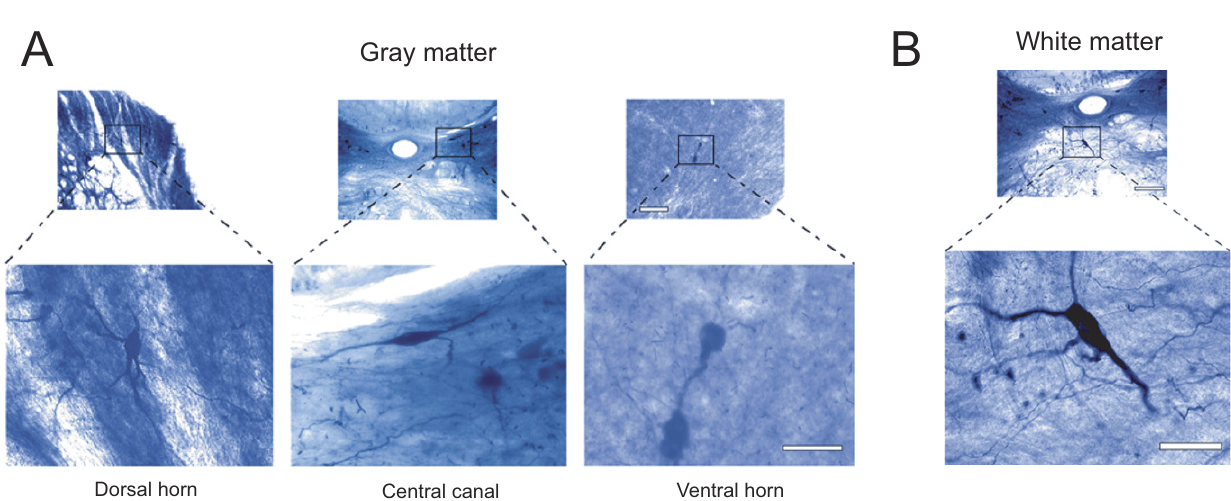
Figure 4. Morphology of NADPH-d neurons located in the spinal cord. Gray matter neurons have a varied morphology, including poorly ramifi ed bipolar neurons from the central canal and extensively ramifi ed multipolar cells from the dorsal horn of the cervical enlargement (A) . The dendritic arborization of white matter cells is exuberant, frequently projecting towards the gray matter (B) . Scale bars: 100 µm (lower magnifi cation); 50 µm (enlargements).